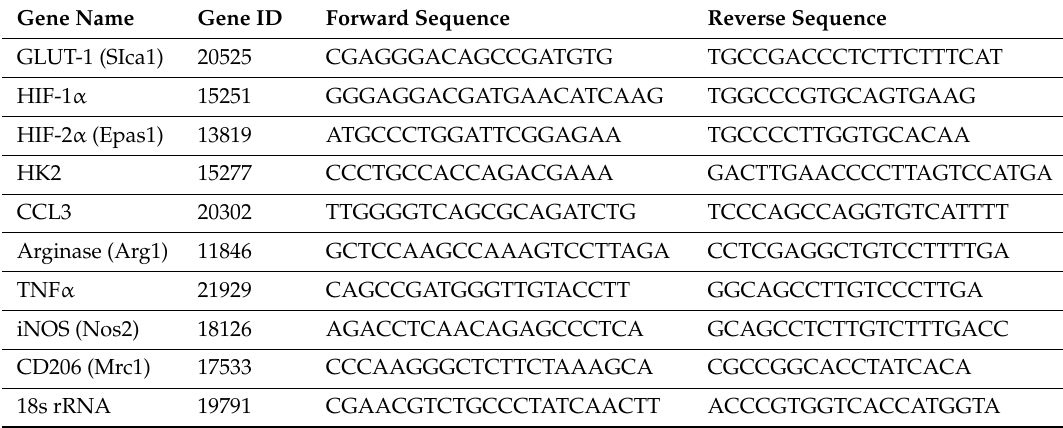
Table 1. RT-PCR primer